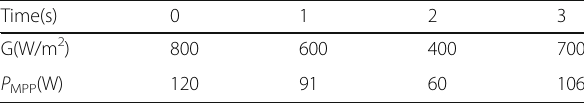
Table 3 Simulated conditions for step varies in